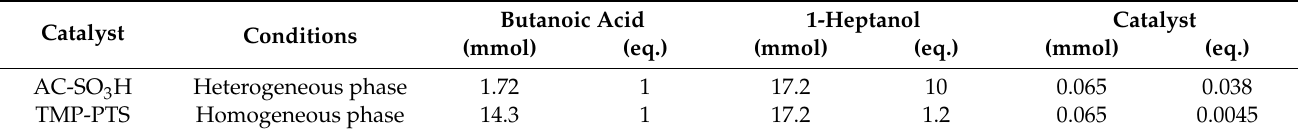
Table 2. Experimental parameters used in the synthesis of the heptyl butanoate ester: type of catalyst, type of phase, and quantities of the substrates and catalyst